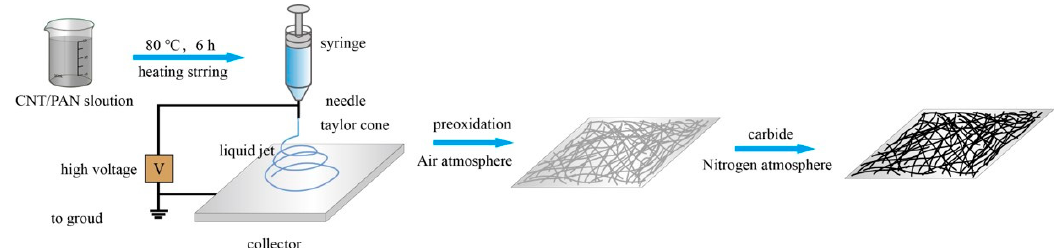
Figure 1. Schematic illustration of the fabrication process of polyacrylonitrile (PAN)-derived electrospun carbon nanofiber mats.